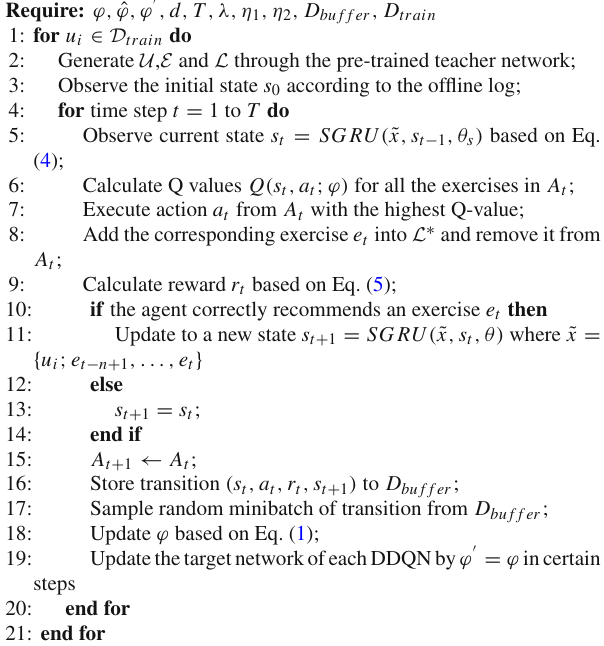
Algorithm 1 Training Algorithm of TERD Framework